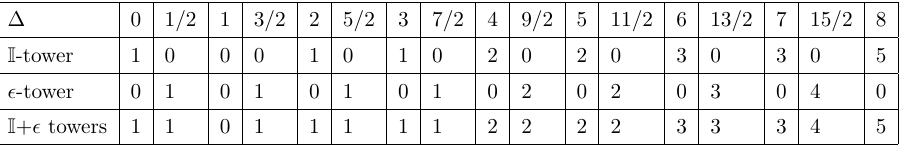
Table 5. Multiplicities of NS